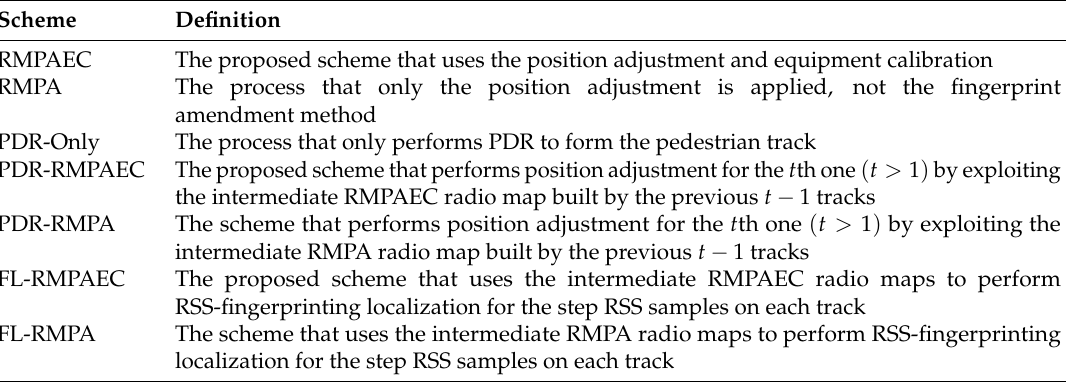
Table 1. Key comparison